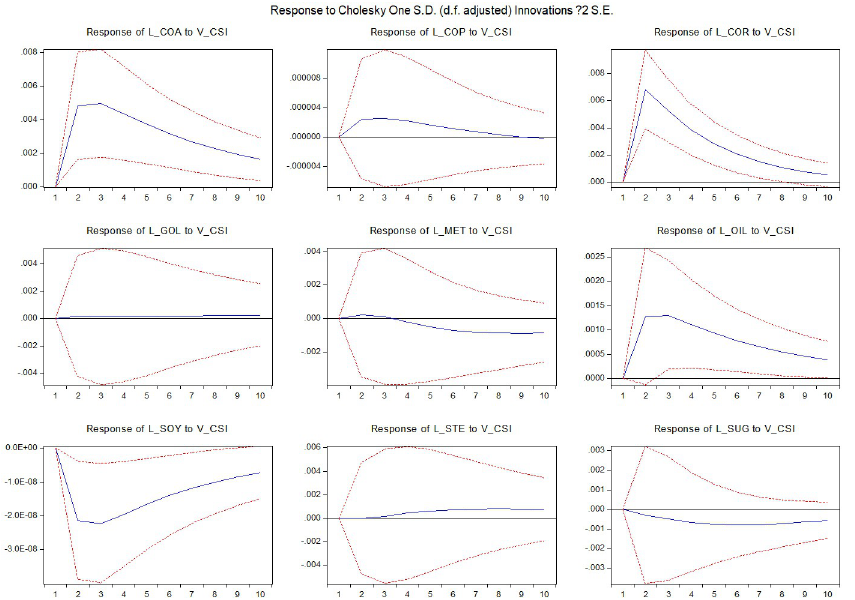
Fig 4. Impulse response functions of market i illiquidity to CSI300 index volatility. The figure presents the response of market i illiquidity (i = coa, cor, cop, gol, met, oil, soy, ste, sug) to CSI300 index volatility shocks. The sample runs from January 1, 2010 to March 22, 2021. The dotted lines are confidence bands based on Monte Carlo simulated standard errors.